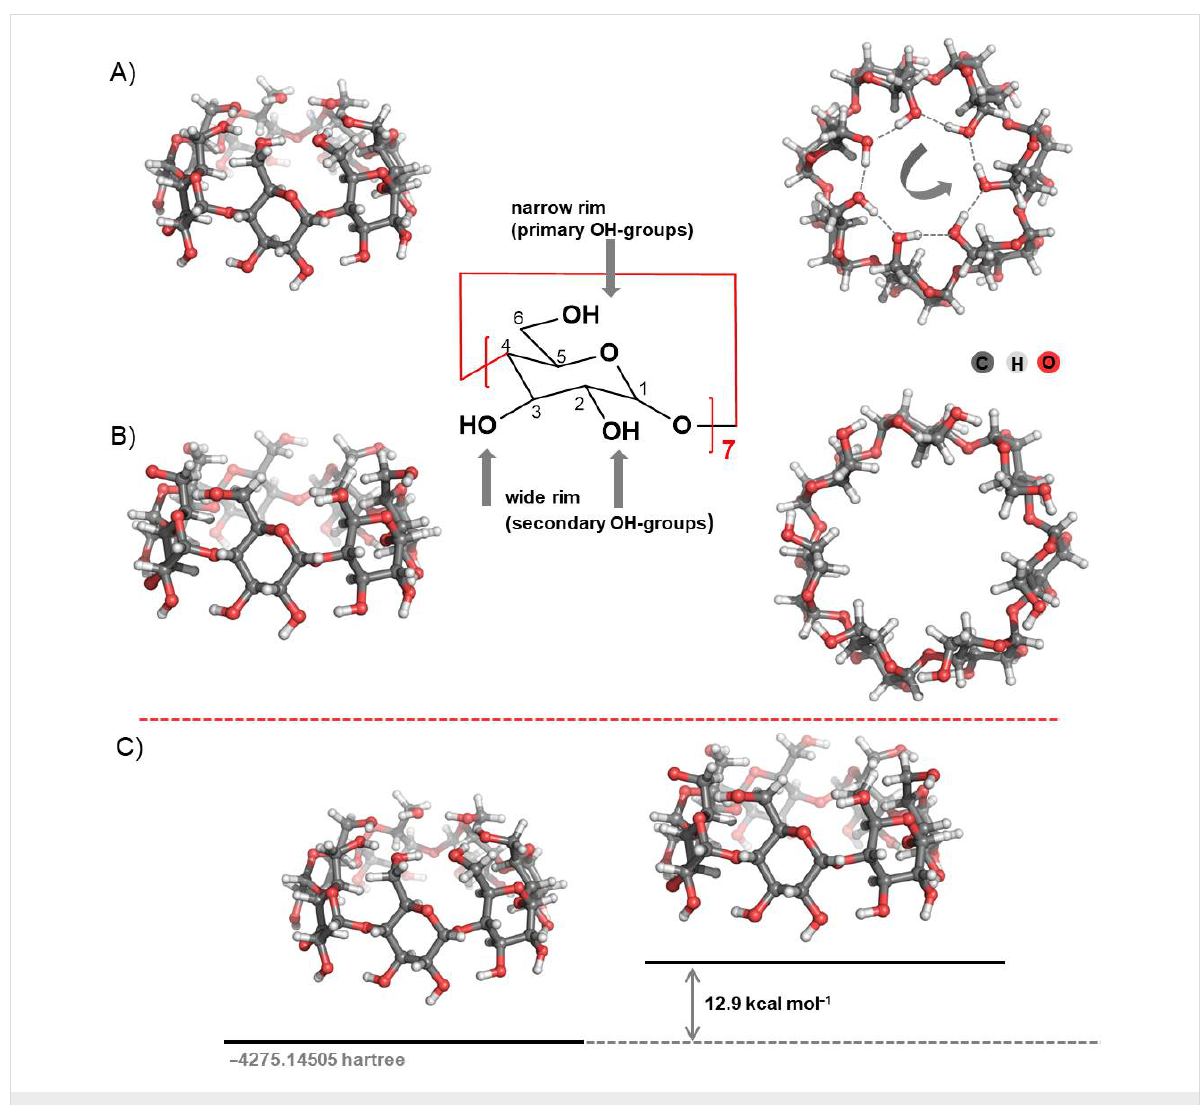
Figure 1: M062X/6-31G(d,p) optimized structure of nonhydrated β -CD in two projections (left: a side view and right: a top view): (A) structure with oppositely oriented intramolecular hydrogen bonds at both rims: looking from the top (the narrow rim side) the direction of the wide rim hydrogen bonds is CW, while the orientation of the narrow rim hydrogen bonds is CCW; (B) structure with “open” narrow rim; and (C) energy difference be- tween these two configurations at the M062X/6-311++G(d,p)//M062X/6-31G(d,p) level of